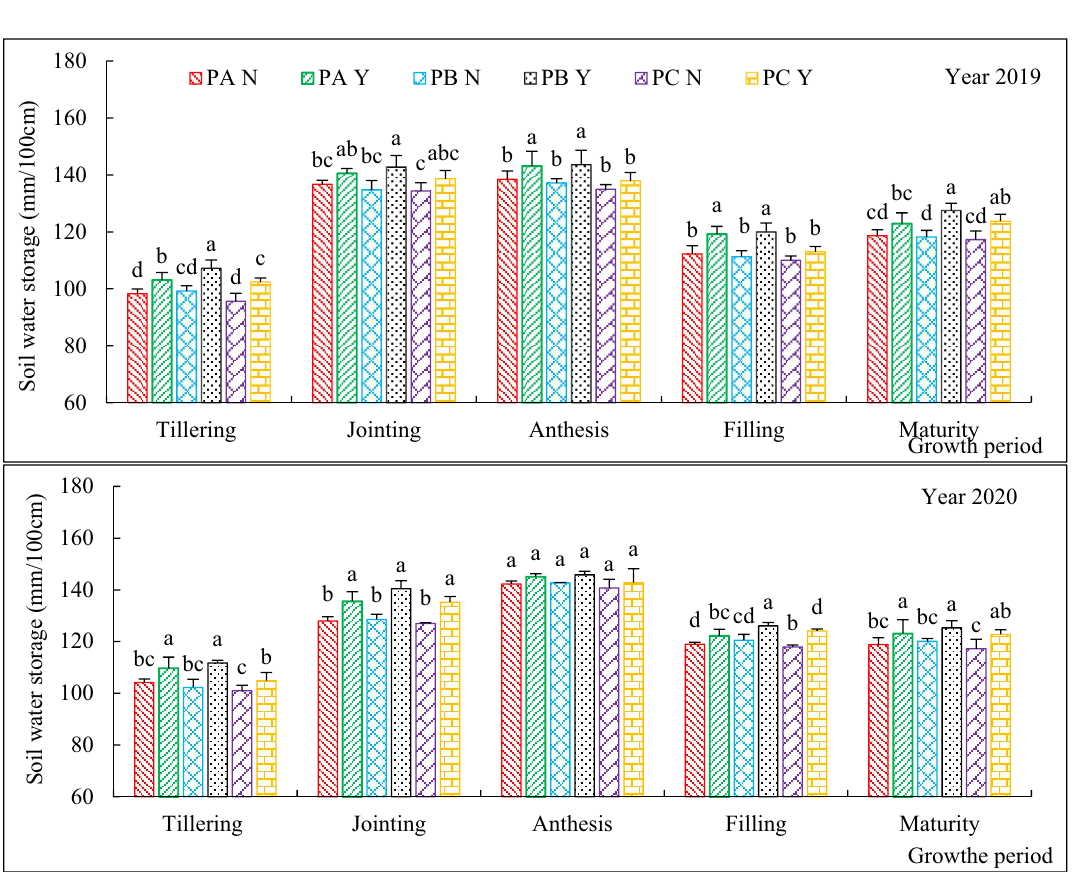
Figure 3. Soil water storage in the 0–100 cm soil layer as affected by planting patterns and super absorbent polymers in 2019–2020. Notes Smaller bar represents the standard error of mean (n = 3); Different lowercase letters stand for significance at 0.05